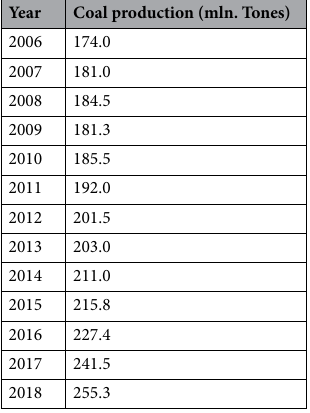
Table 1. Annual coal production statistics for